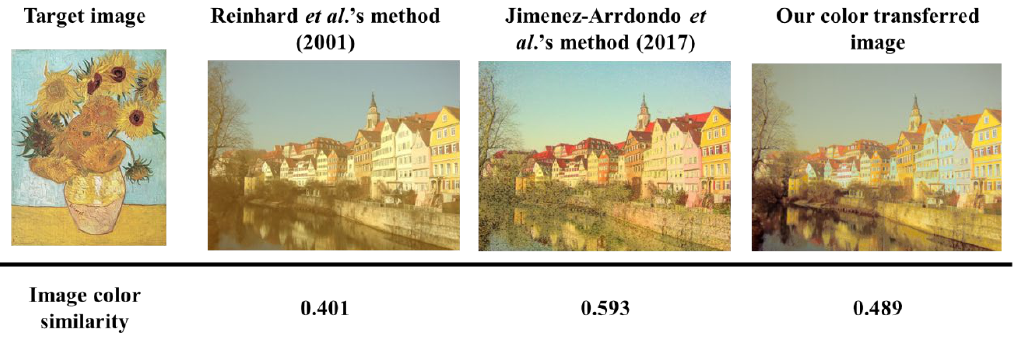
Figure 16. Image color similarity according to the histogram of the target image, other related color transfer resulting images, and our color-transferred image.